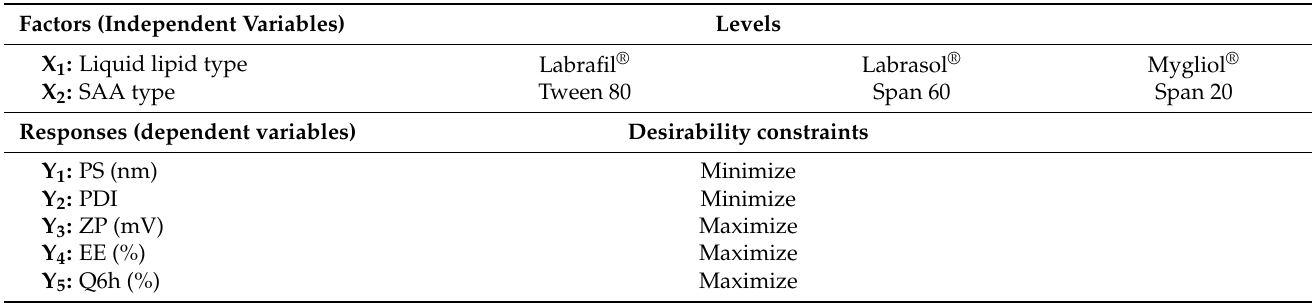
Table 1. The independent and dependent variables for the 3 2 full factorial design used for the optimization of ZMP-loaded NLCs